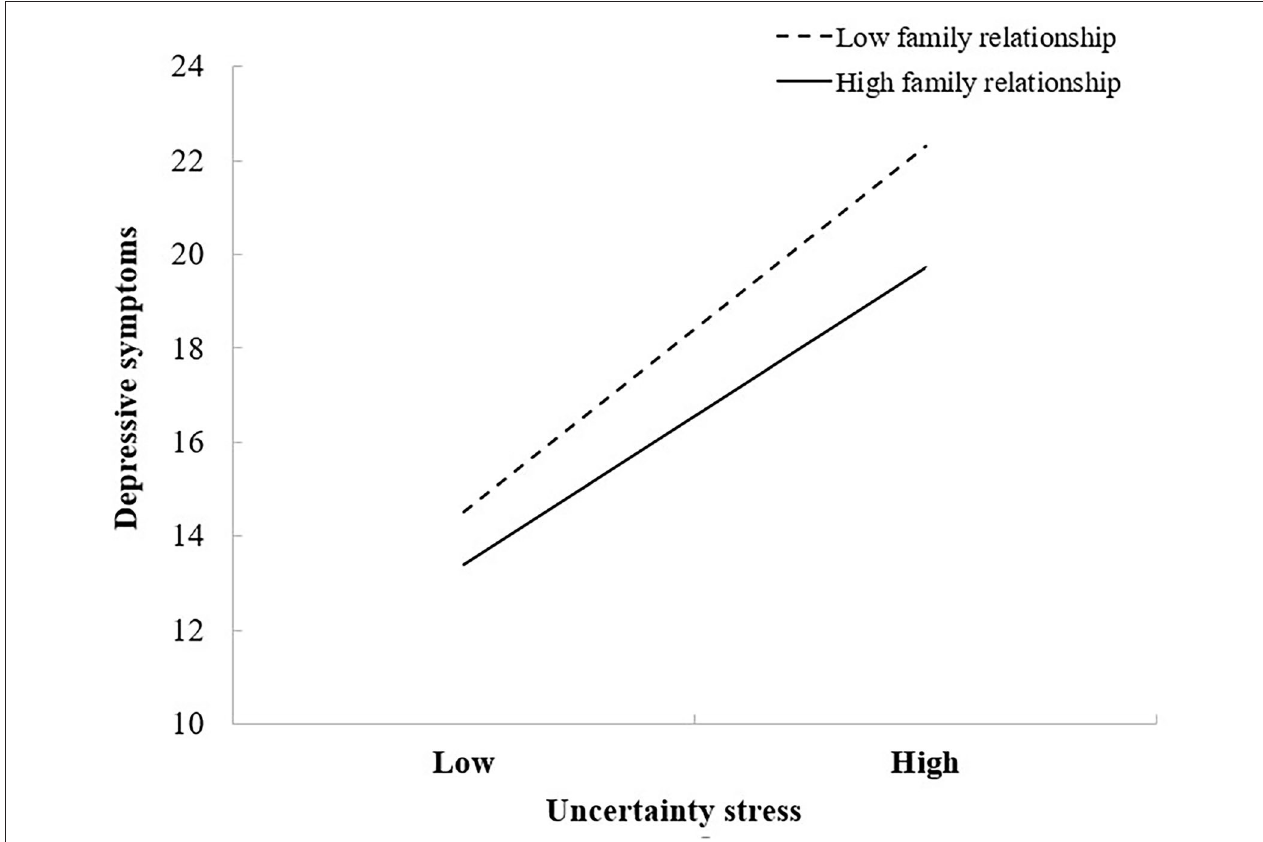
FIGURE 3 | Family relationship moderates the effect of uncertainty stress on depressive symptoms. Covariates controlled in the modeling analysis were the following: Gender, Age, Grade, Only-child, Ethnicity, Residence, Parent’s marriage and education, Living expenses, Sexual orientation, and Academic